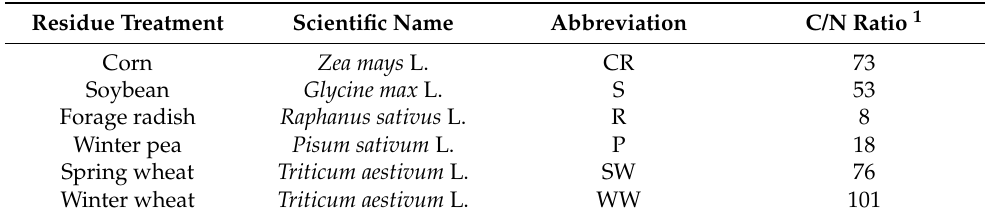
Table 1. Six crop residue treatments used for the five incubation cycles, their scientific name, abbrevi- ation, and C/N ratios. Residue Treatment Scientific Name Abbreviation C/N Ratio 1 Corn Zea mays L. CR 73 Soybean Winter